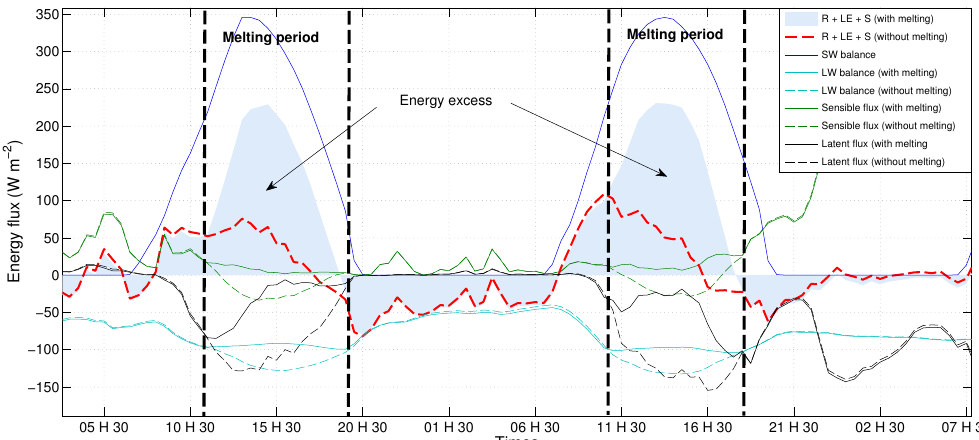
Fig. 5. Energy fluxes during two consecutive days of melting (18 and 19 August). Comparison between two cases: (i) no phase change is taken into account and firn temperature can artificially exceed 0 ◦ C (dashed line); (ii) melting is taken into account (lines and filled blue